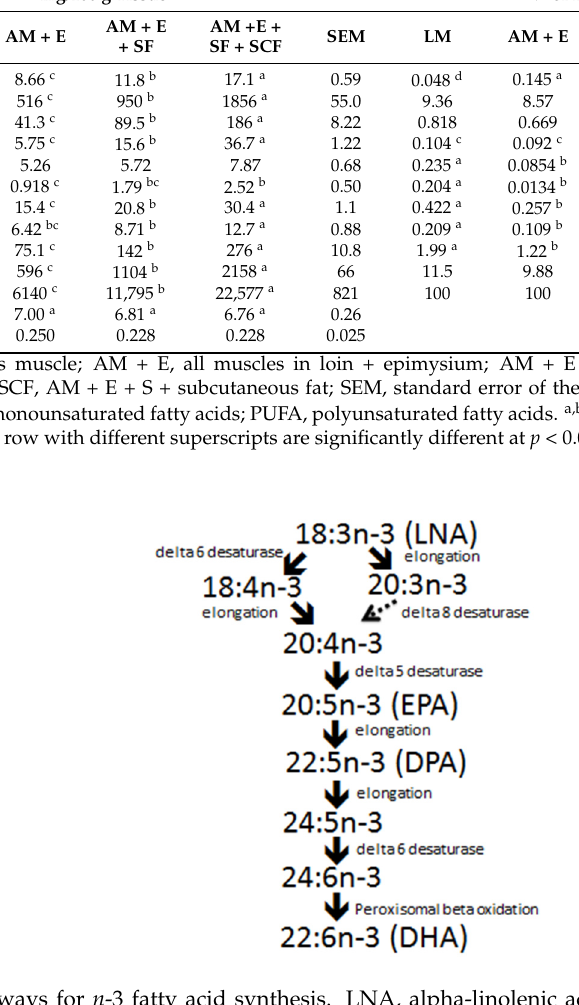
Figure 2. Pathways for n ‐ 3 fatty acid synthesis. LNA, alpha ‐ linolenic acid; EPA, eicosapentaenoic acid; DPA, docosapentaenoic acid; DHA, docosahexaenoic acid.